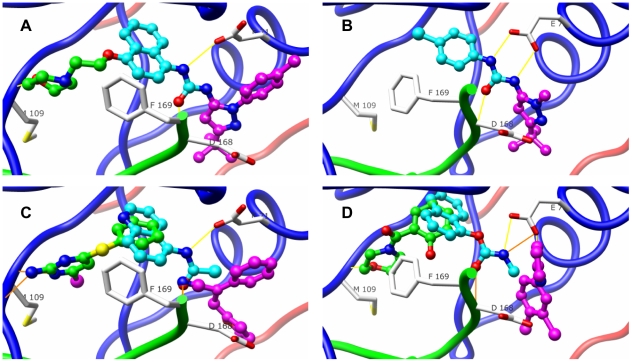
Top ranked fragments from the virtual screen mimic portions of known inhibitors of p38 MAP kinase.(A) The high affinity inhibitor BIRB796 (stick) is shown bound to p38 MAP kinase (1kv2). Key hydrogen bonding interactions—between the morpholino group and the main chain amide of residue Met109, the urea group and the side chain carboxylate group of conserved residue Glu71, and the main chain amide of residue Asp168—are illustrated with yellow lines. Portions of the ligand are colored for comparison with fragments in panels (C) and (D). (B) A low-affinity ligand BMU (stick) is shown bound to the allosteric pocket (1kv1). (C) Three partially overlapping top fragment hits (stick) identified from virtual screening against the 1kv2 structure are shown: a pyridinyl-imidazole type of fragment (carbon atoms colored green, rank 155 in the virtual screen) bound to the ATP binding pocket; a urea-like moiety on a substituted naphthyl ring (carbon atoms colored cyan, rank 55) interacting with the Glu71 sidechain and the lipophilic pocket; and a substituted heterocyclic ring (carbon atoms colored magenta, rank 165) deeply buried into the allosteric binding pocket. (D) The overlap of three top scored fragment hits identified from virtual screening against the 1kv1 structure (ranks 6, 136 and 210). Molecular images were generated with UCSF Chimera [42].